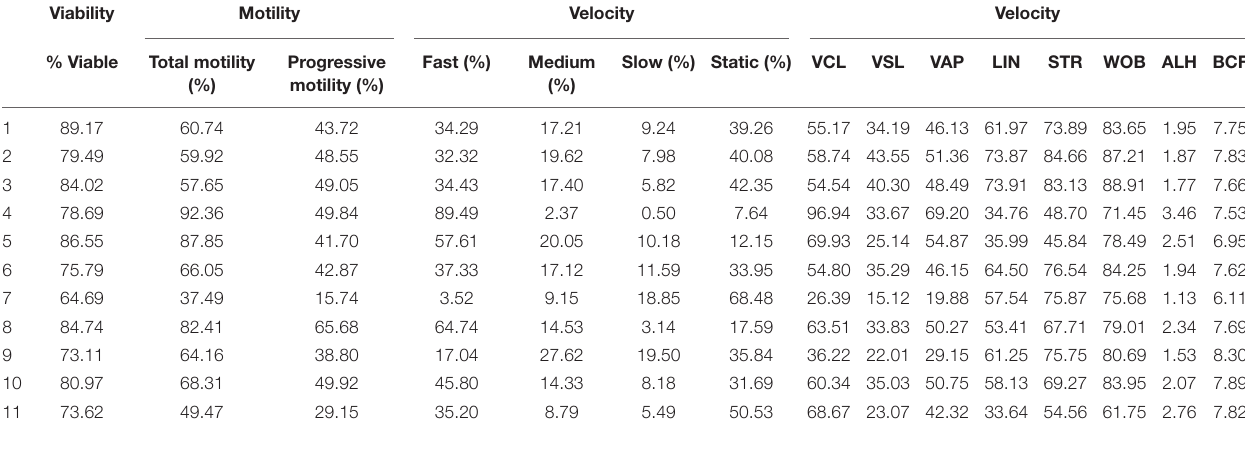
TABLE 4 | Sperm viability and motility parameters from samples used to analyze sperm DNA fragmentation using alkaline and neutral Comet